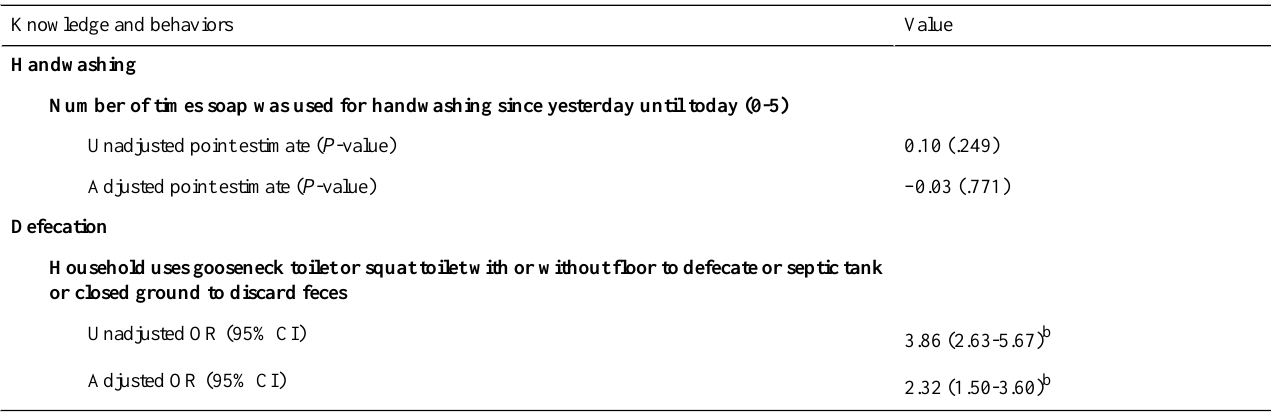
Table 4. Use of technology to access health information and services and impact on behavior of hygiene and defecation in Banyuasin, Kubu Raya, and Katingan in 2018.